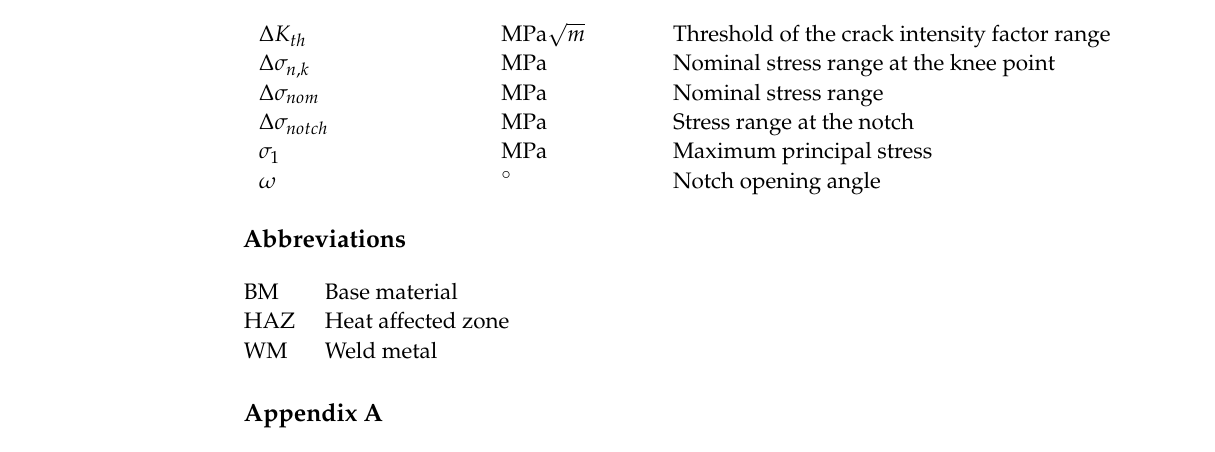
Table A1. Results of the statistical evaluation of the S–N curves with maximum